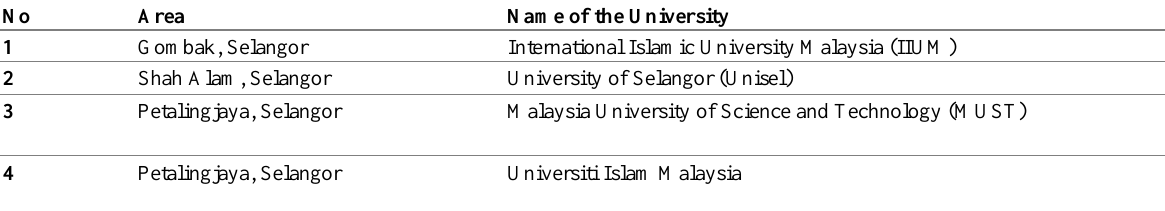
Table 1: The field of